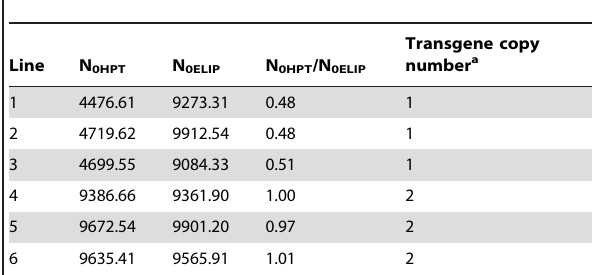
Table 3. Determination of transgene copy number of six transgenic tomato plants by standard addition qPCR